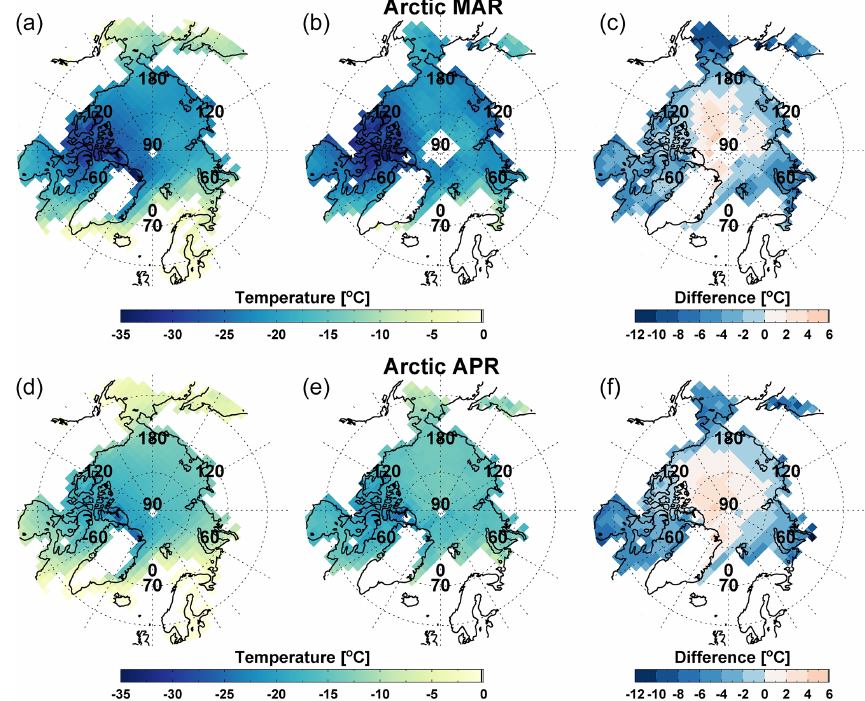
Figure 7. Monthly surface air temperature for the mean field (a, d) , the enhanced BrO case (b, e) , and surface air temperature anomalies (difference of surface air temperature between the enhanced BrO case and the mean field) (c, f) over the Arctic in March (a–c) and April (d–f) .